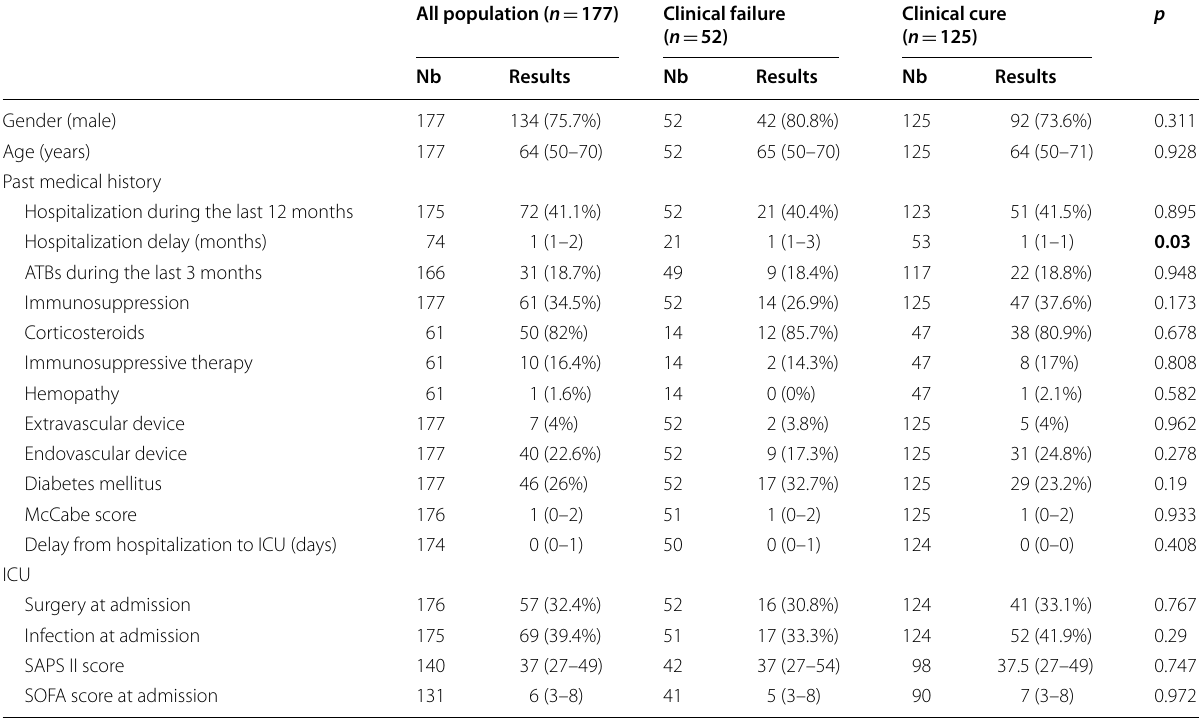
Table 1 Baseline characteristics of patients at ICU admission